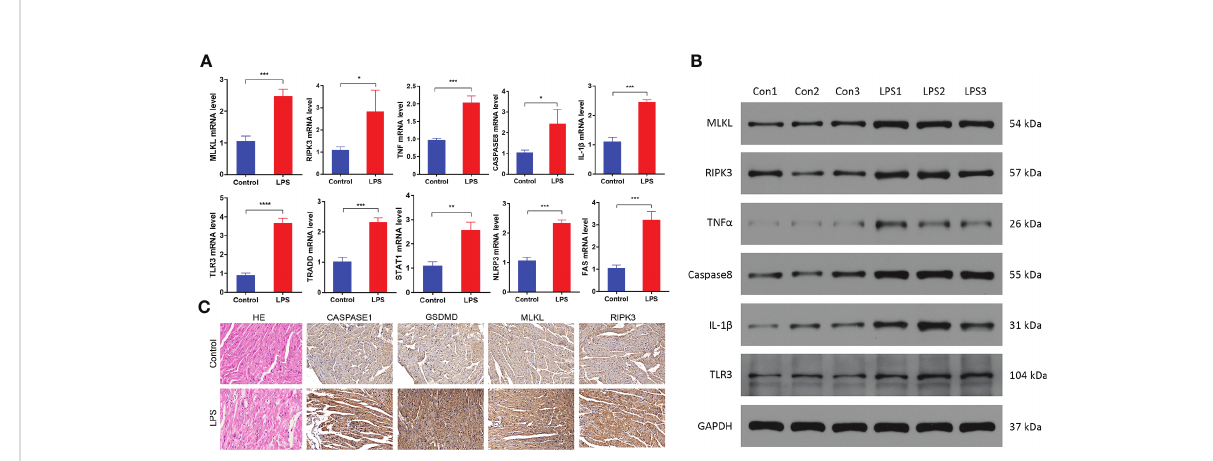
FIGURE 7 Necroptosis is activated in the heart tissues of the sepsis-induced myocardial dysfunction model mice. (A) QRT-PCR analysis results show the relative expression levels of TNF, IL-1 b , MLKL, RIPK3, CASPASE8, TLR3, TRADD, STAT1, NLRP3 and FAS mRNAs in the heart tissues from the control and SIMD group mice (n = 3 per group). GAPDH was used as the internal control and used for normalizing the mRNA expression data. (B) Western blot analysis results show the expression levels of TNF a , IL-1 b , MLKL, RIPK3, CASPASE8, and TLR3 proteins in the heart tissues from the control and SIMD group mice (n = 3 per group). GAPDH was used as the loading control. (C) Representative images show the immunohistochemical analysis of CASPASE1, GSDMD, MLKL, and RIPK3 protein levels in the heart tissues from the control and SIMD group mice. Scale bar: 50 m m. Data are presented as mean ± SEM. *p < 0.05, **p < 0.01, ***p < 0.001, ****p <